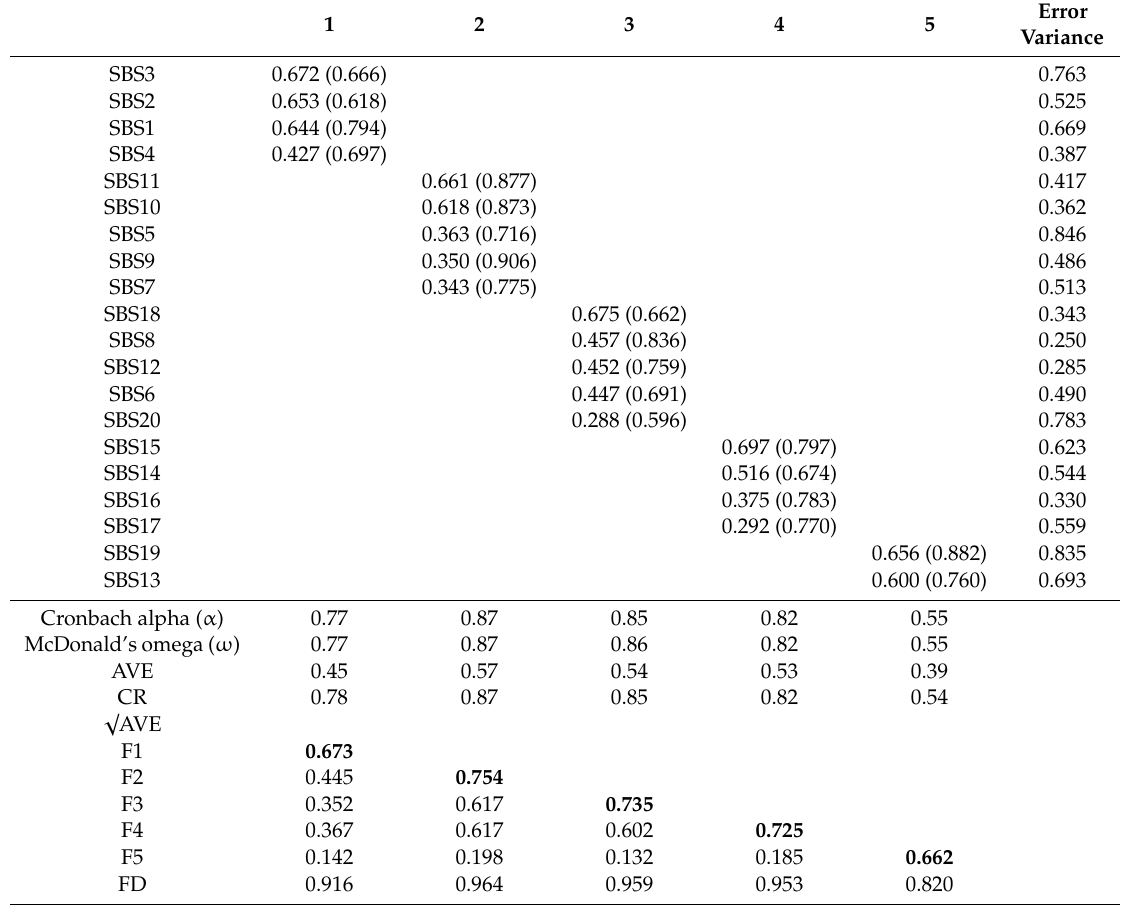
Table 1. Parallel and confirmatory factor analysis of the SBS: Factor loading and error variance.